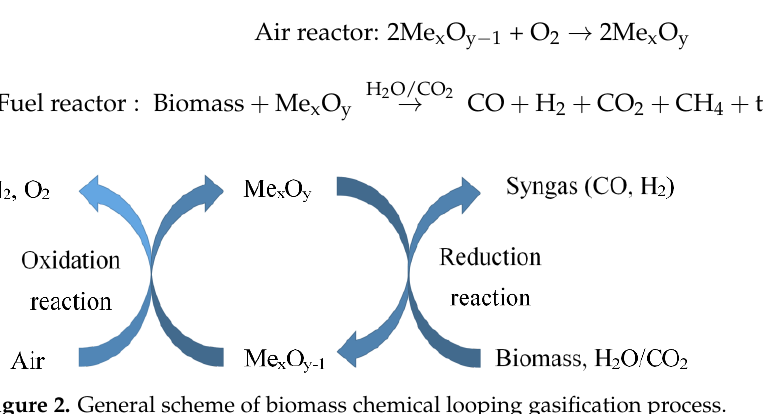
Table 1. Chemical reactions in fuel reactor [19,21,22] .